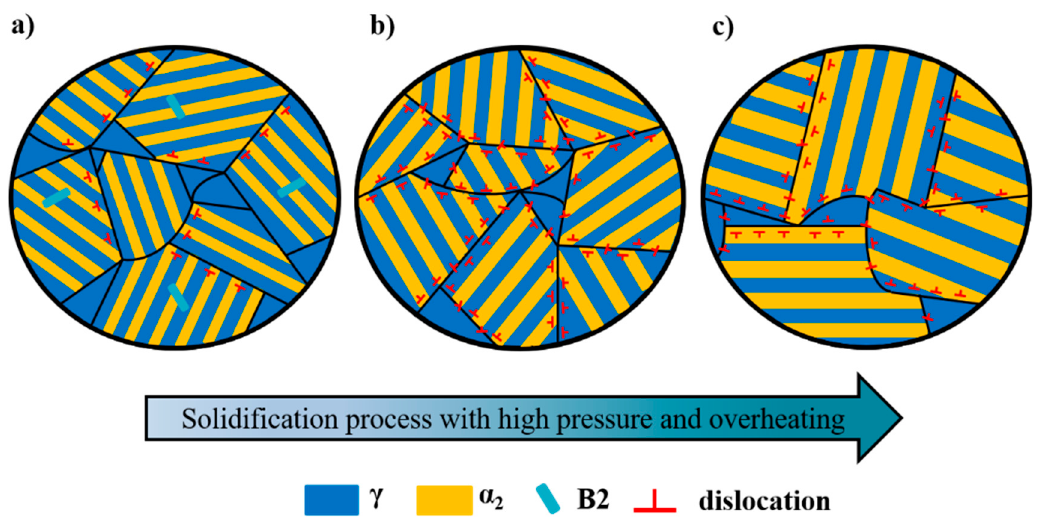
Figure 7. The strengthening mechanism in the microstructure of the Ti-48Al-2Cr alloy ( a ) ambient pressure, 1873 K; ( b ) 5 GPa, 1873 K; ( c ) 5 GPa, 1973 K.